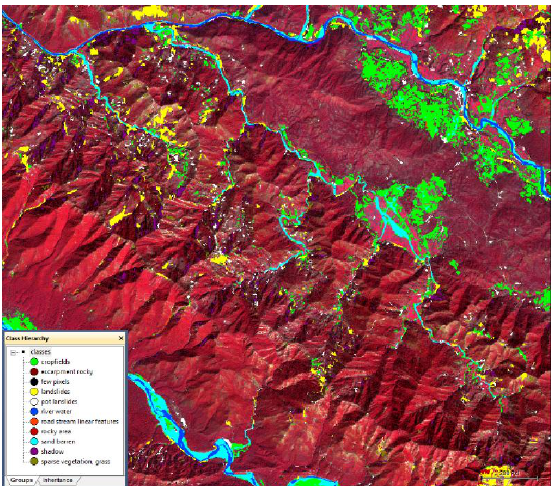
Figure 5. Final outcome of image segmentation with false positives and